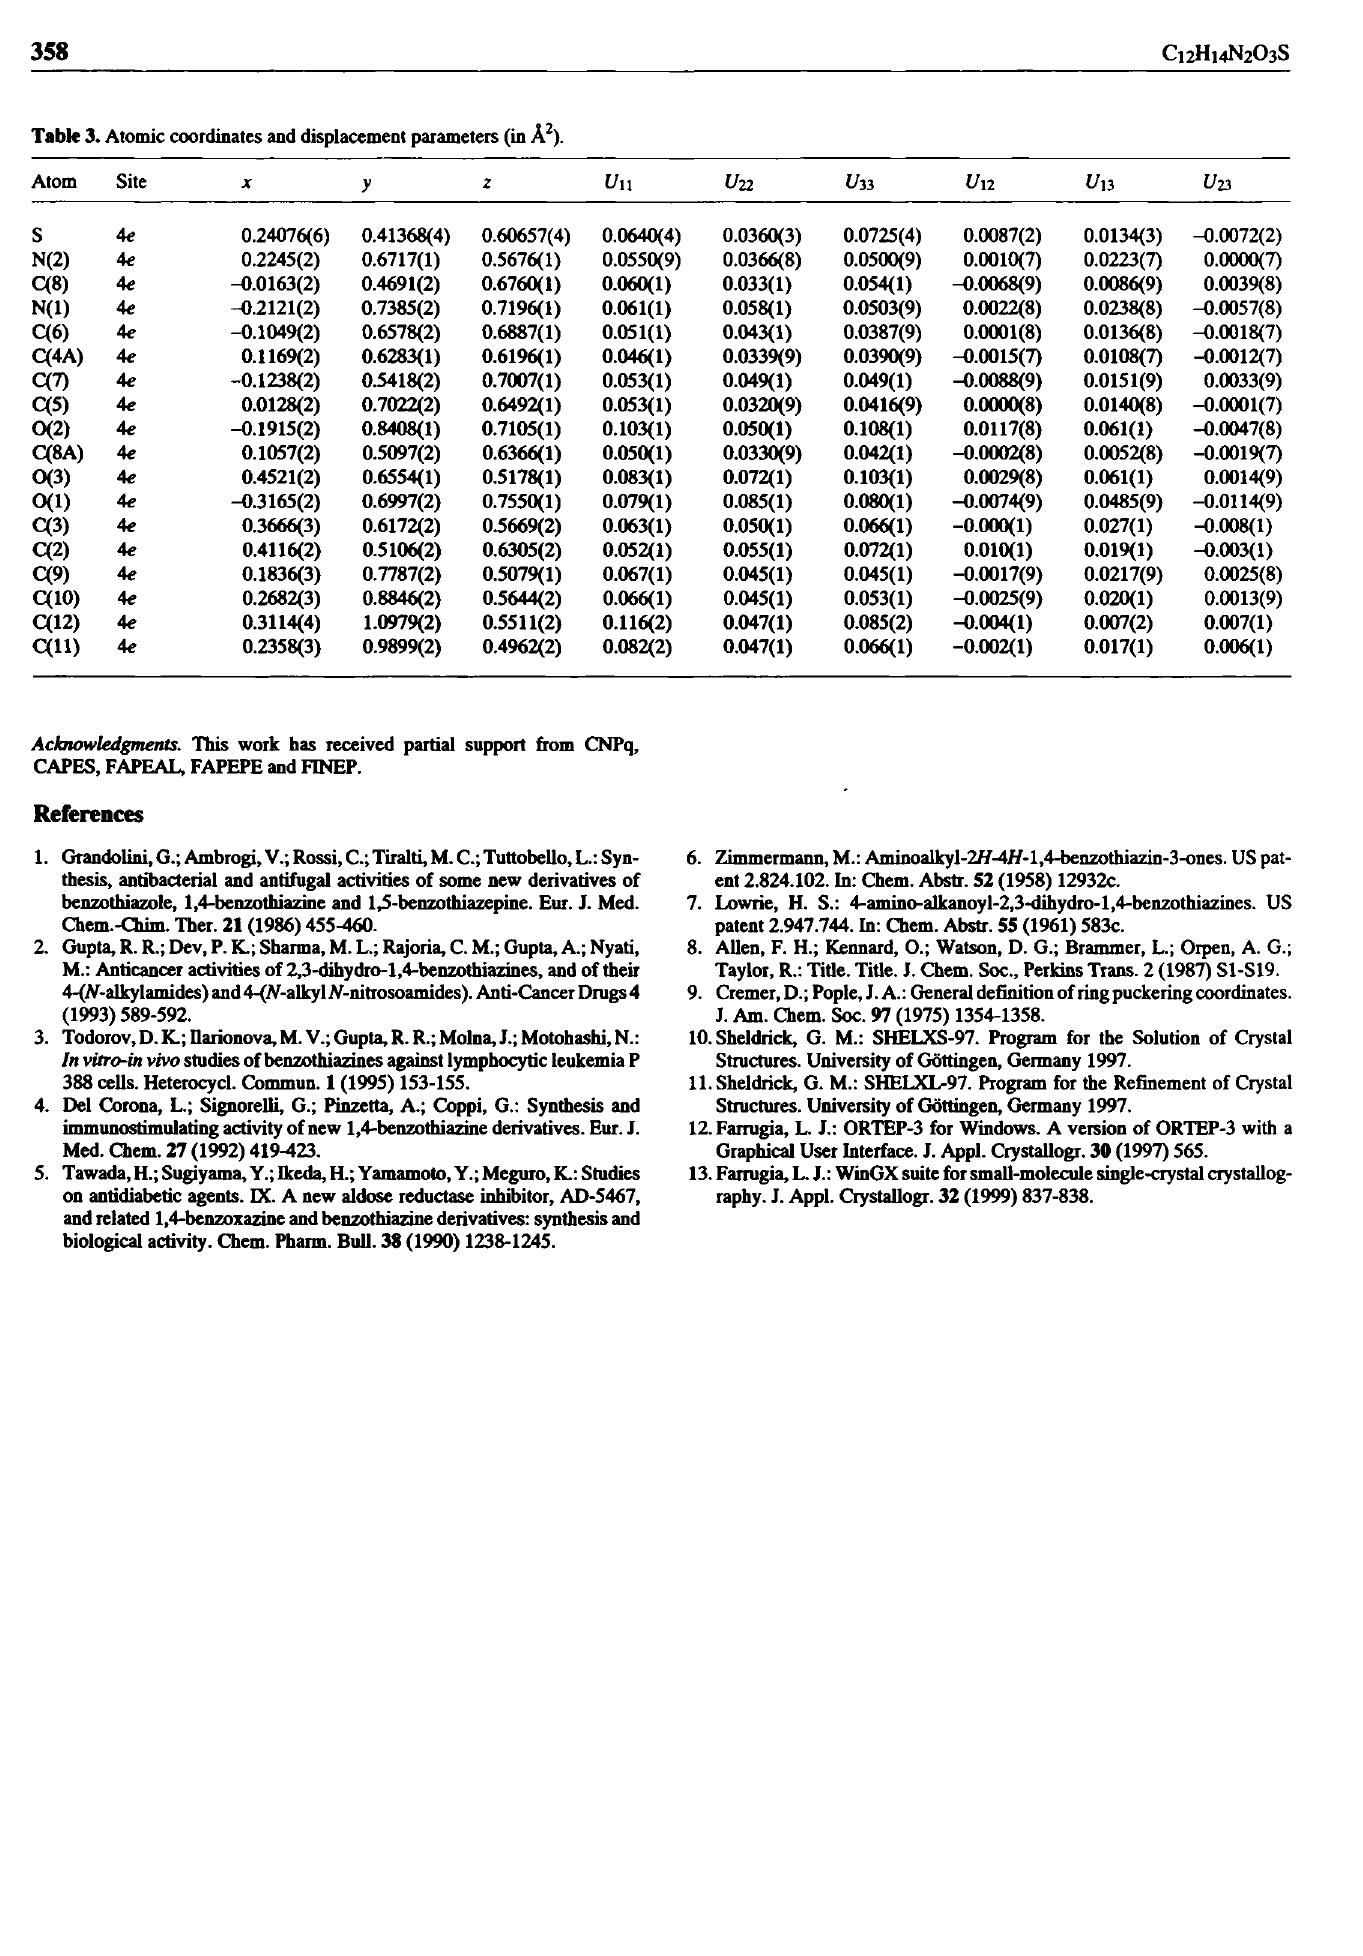
Table 3. Atomic coordinates and displacement parameters (in A 2